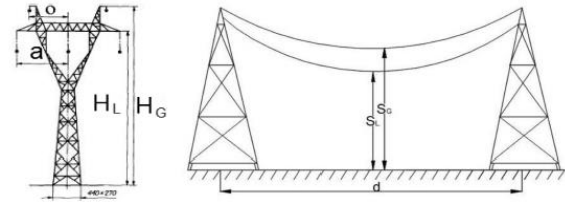
Fig. 2. Geometry of a system power line – house.